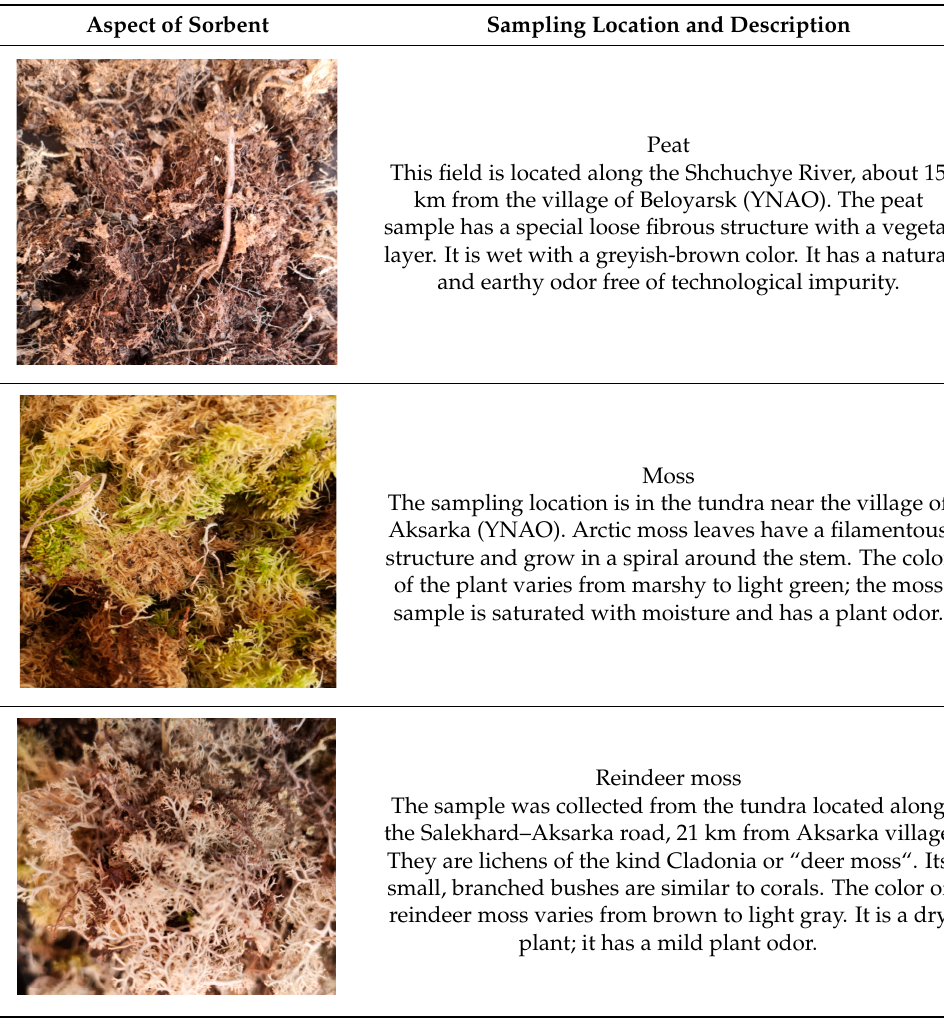
Table 2. The aspect, sampling location, and description of the sorbent samples.